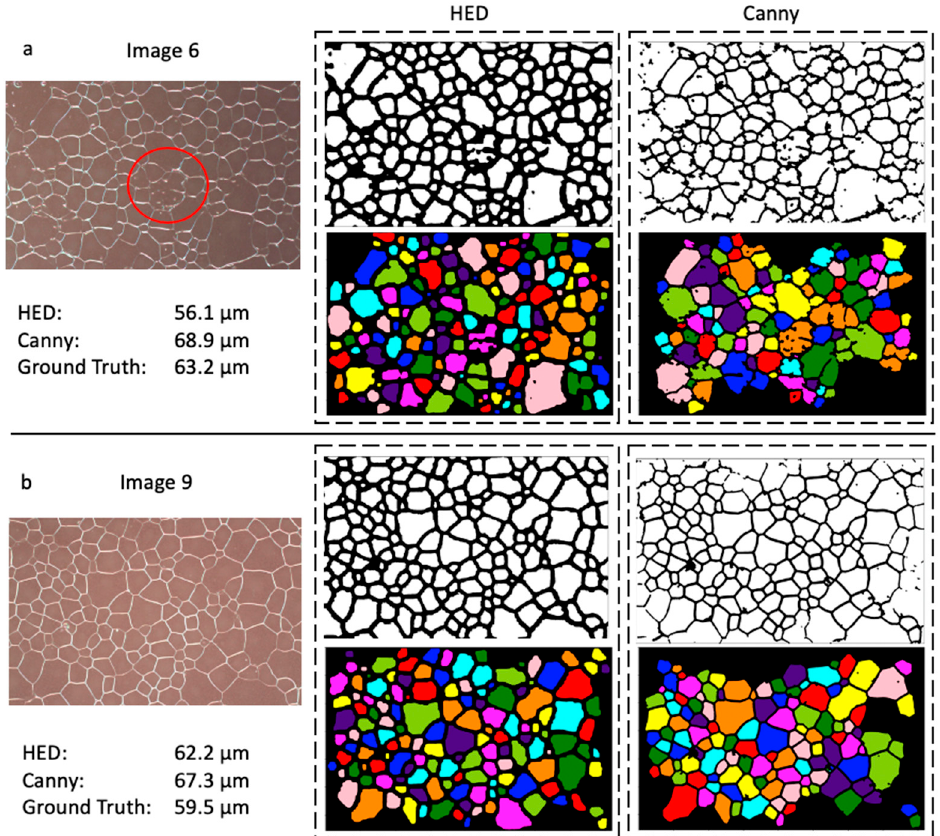
Figure 6. A visual representation of HED and Canny processing methods after morphological op- erations on image 6 ( a ) and image 9 ( b ) from Figure 5. The circled area represents a zone of low resolution.